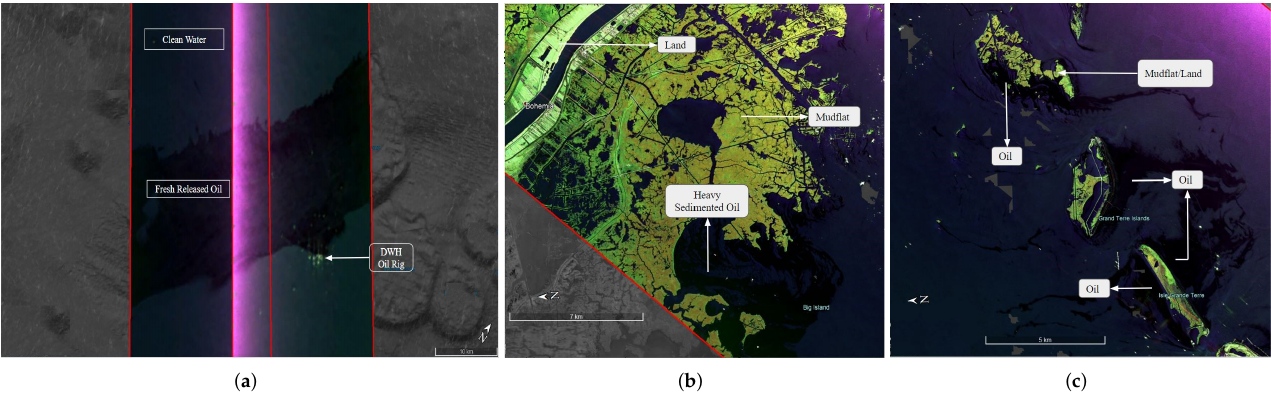
Figure 5. Patches of UAVSAR images considered in study: ( a ) shows surface oil and clean water near DWH rig site; ( b ) shows oil heavily mixed with sediment and other surfactants that has moved into the interior bay labeled as Heavy Sedimented Oil. ( c ) shows weathered oil on the GOM side of the barrier islands partially mixed with sediment labeled as oil